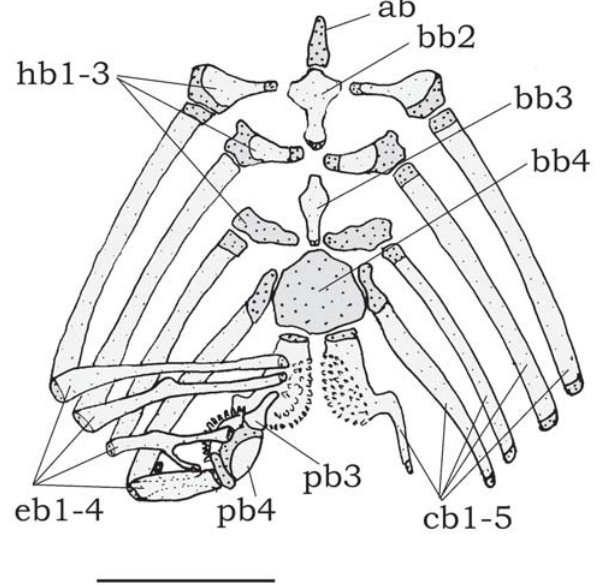
Fig. 5. Pharyngeal arches of Tatia gyrina , INPA 20971, 28.0 mm SL. Dorsal view. Abbreviations: ab , anterior (first) basibranchial; bb2 , basibranchial 2; bb3 , basibranchial 3; bb4 , basibranchial 4; cb1-5 , ceratobranchials 1 to 5 (anterior to posterior); eb1-4 , epibranchials 1 to 4 (anterior to posterior); hb1-3 , hypobranchials 1 to 3; pb3 , pharingobranchial 3; pb4 , pharingobranchial 4. Scale bar = 1.0